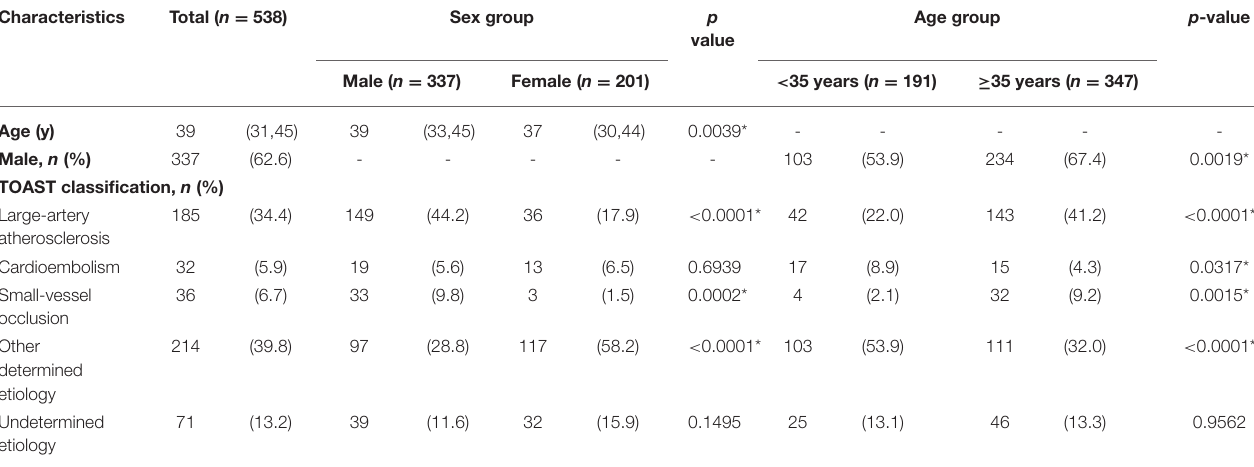
TABLE 1 | Demographic data and TOAST classification.